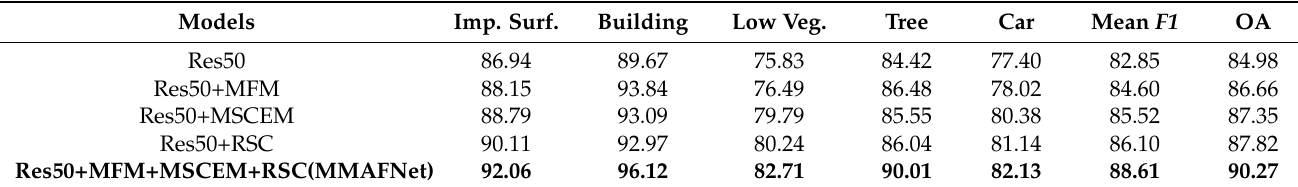
Table 3. Quantitative analysis of a single module ablation experiment on the Vaihingen dataset; the best result (%) is shown in bold. Models Imp.